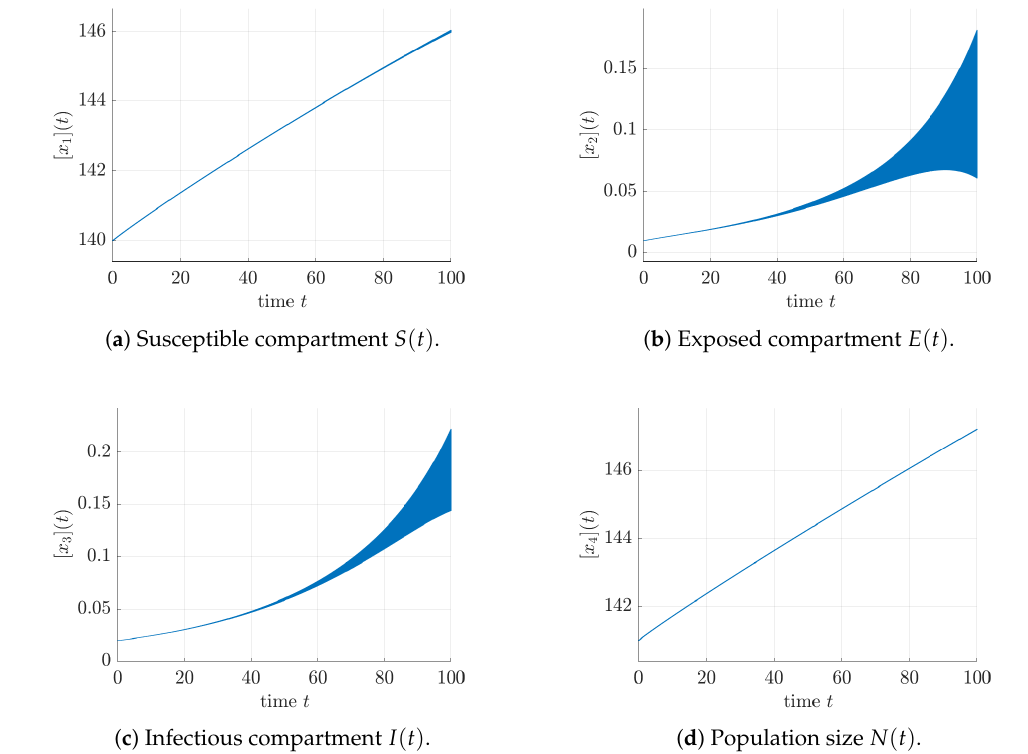
Figure 7. State enclosures for the SEIR model in Scenario 1 with the initial conditions (44).